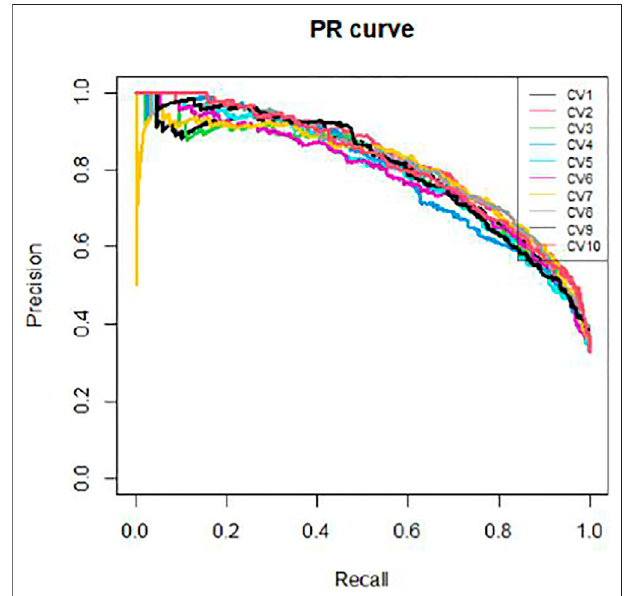
FIGURE 1 | ROC curves of 10-cross validation.